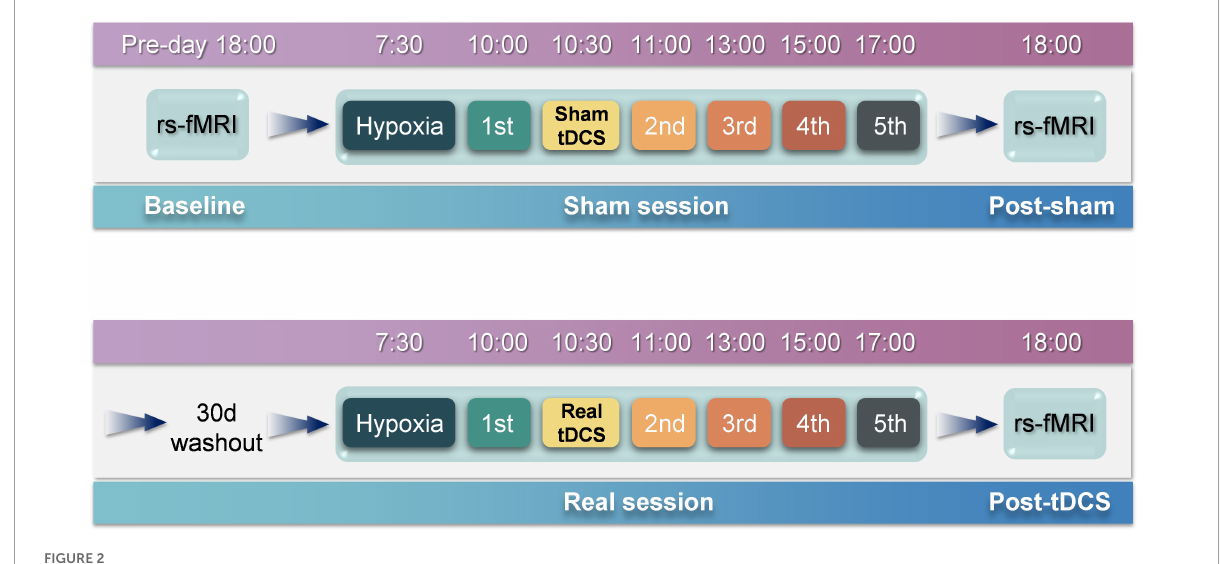
FIGURE2 Experimental procedures. The entire experiment consists of two sessions, i.e., sham and real sessions. The real session is separated from the sham session by 30 days to eliminate after-effects. rsfMRI scans are performed before and after the sham session to obtain baseline and post-sham functional images. After the real session, another rsfMRI scan is performed to obtain post-tDCS functional